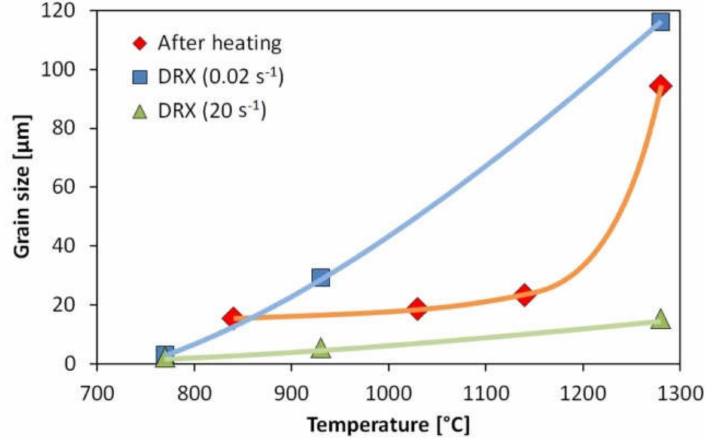
Figure 24. Influence of the processing parameters (heating vs. hot deformation) on austenitic grain size; DRX means dynamic recrystallization for two levels of the nominal strain rate.